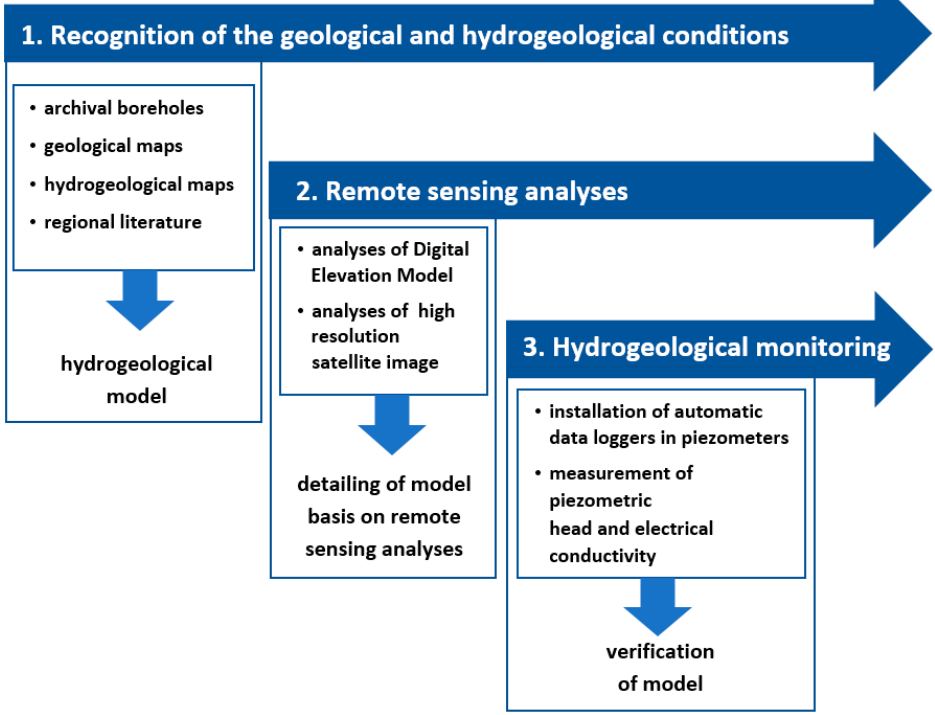
Figure 2. Flow chart of